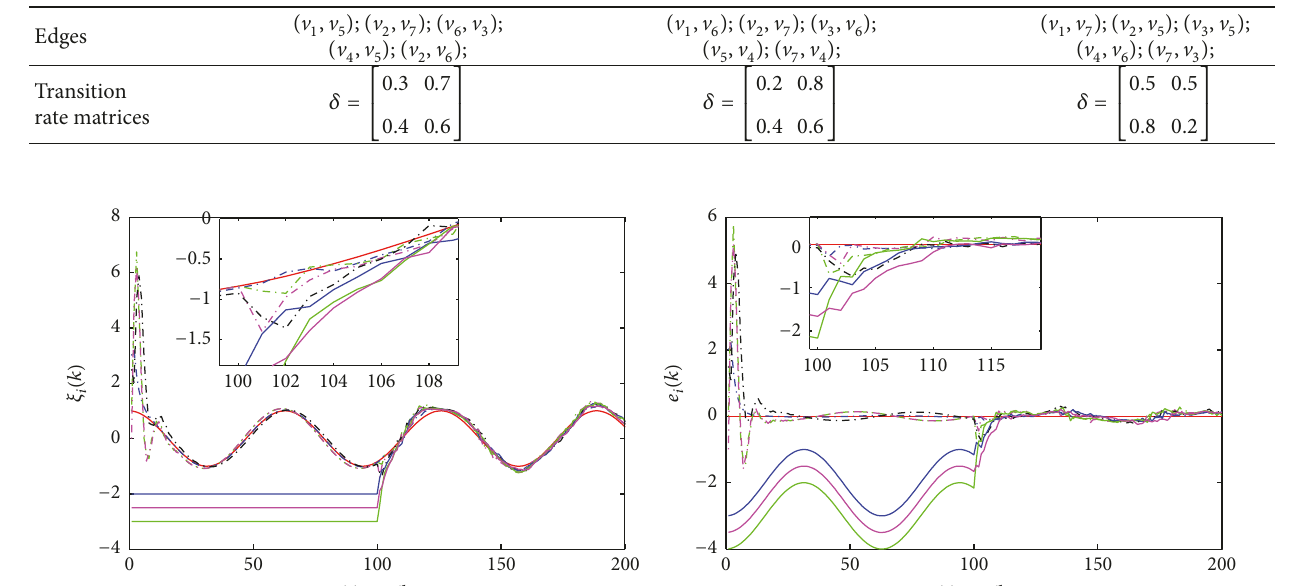
Table 1: Transition rate matrices for Markov chains.